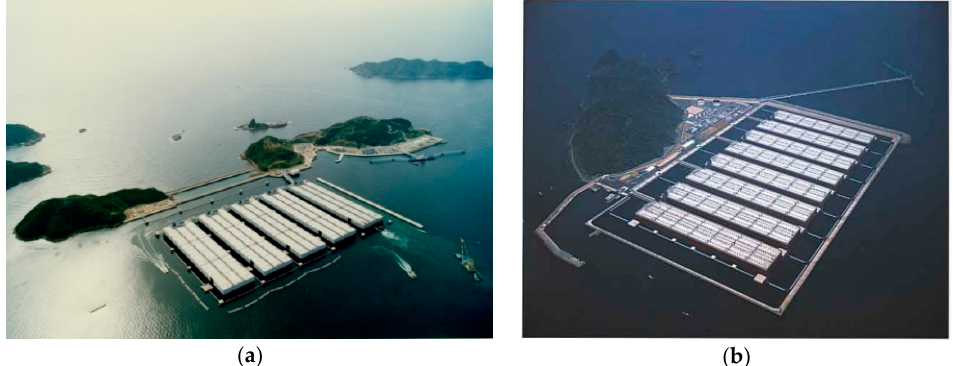
Figure 4. Floating oil storage facilities: ( a ) Kamigoto Oil Storage Base and ( b ) Shirashima Oil Storage Base [7].